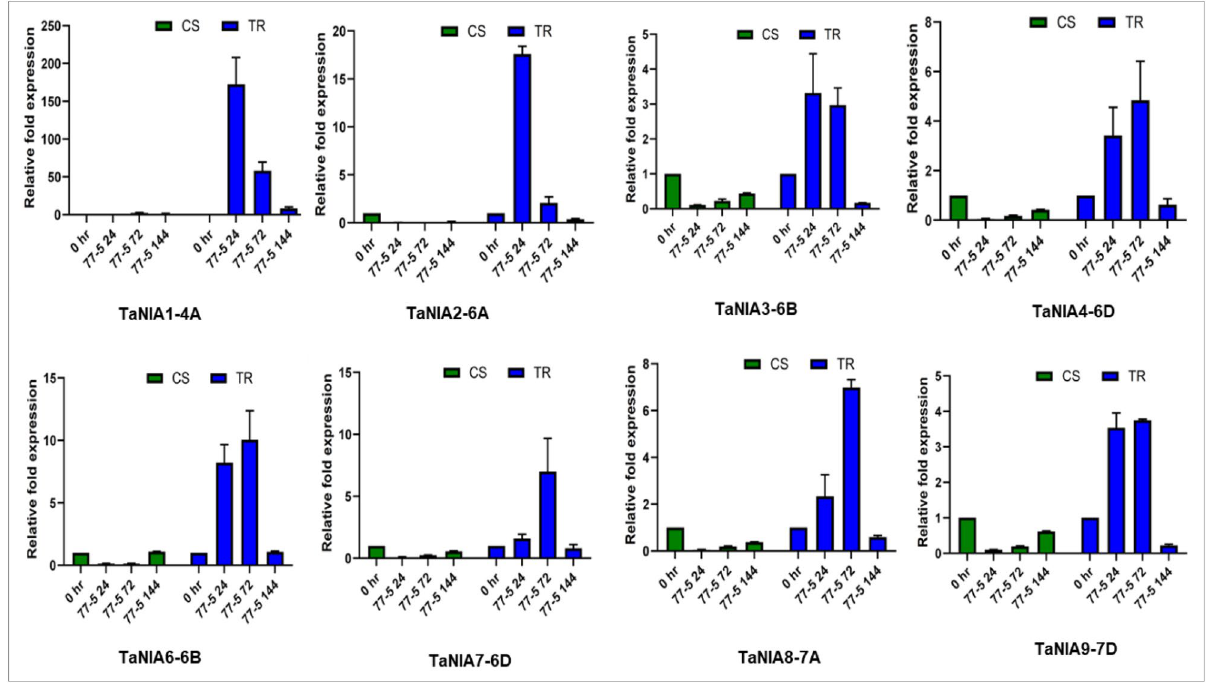
Figure 6. Expression analysis of TaNIA genes in leaves of wheat genotypes Chinese spring (CS) (susceptible) and transfer (TR) (resistant line) inoculated with leaf rust pathotype 77-5. Samples were collected at different time intervals viz., 0 h after inoculation (HAI), 24HAI, 72HAI and 144HAI. Values are means (± SE) of 3 biological replicates. Graphs were created in Graph Pad prism 8 (www. graph pad. com).